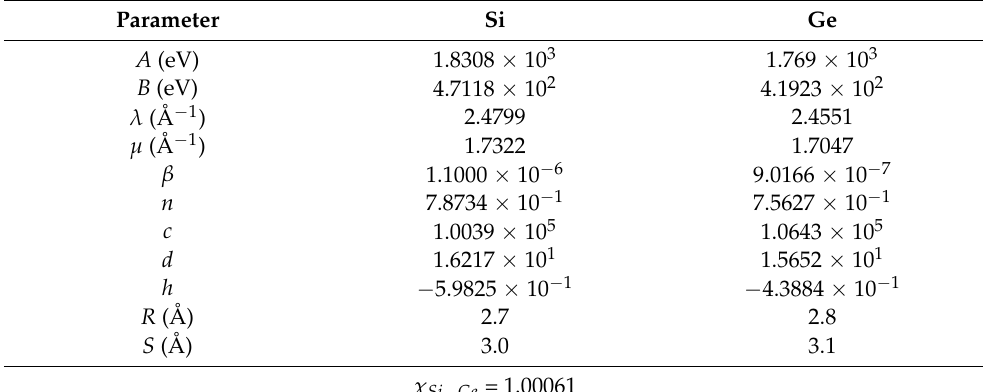
Table 1. Parameters that were used for silicon and